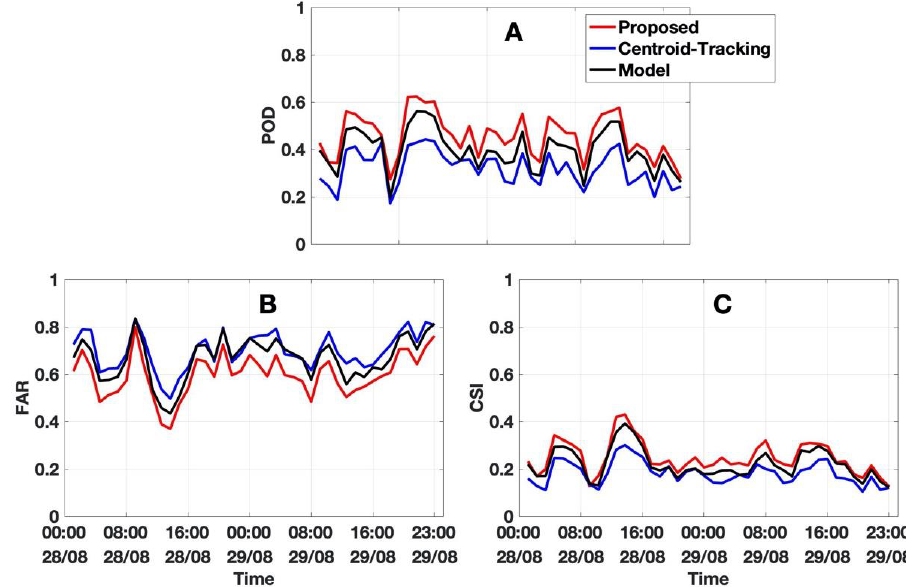
Figure 11. The statistical score of ( A ) the probability of detection, ( B ) the false alarm rate, and ( C ) the critical success index. The red, blue, and black lines show the proposed, the centroid-tracking, and the model results. A set of 48 h of data from 28−29 August 2017 is used in the analysis.